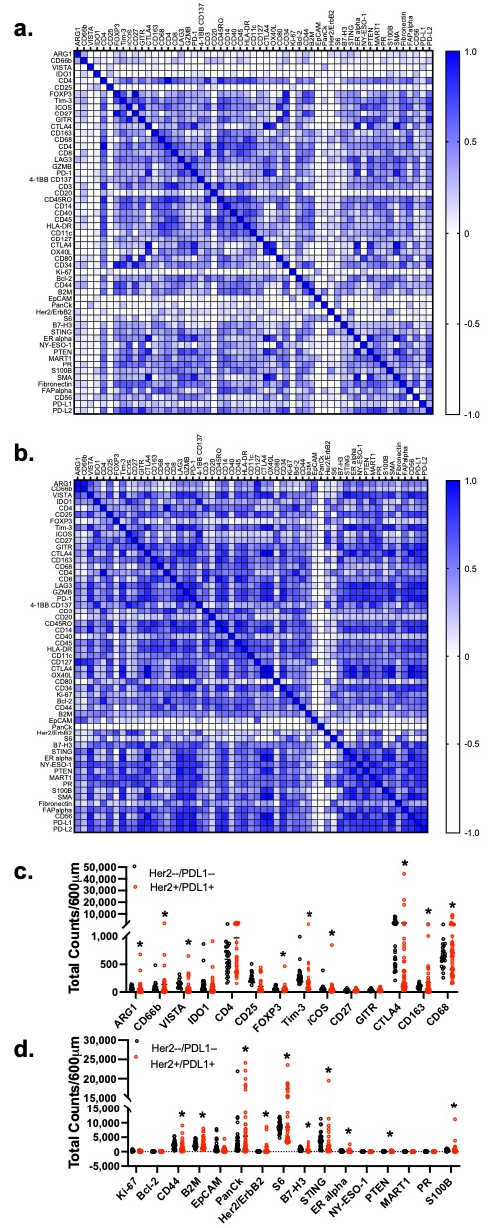
Figure 3. Correlation matrix of the expression of immune and tumor protein markers. Correlation matrices of the expression of immune and tumor protein markers of FFPE tissues obtained from ( a ) HER2 − ve and ( b ) HER2 +ve gastric cancer patients. Analysis of tumor cell markers ( c ) between HER2 − ve and HER2 +ve gastric cancer patients. Analysis of immunosuppressive (MDSC, Tregs and TAM) markers in ( d ) HER2 − ve and HER2 +ve gastric cancer patients. * p < 0.05 compared to HER2 − ve gastric cancer patients.